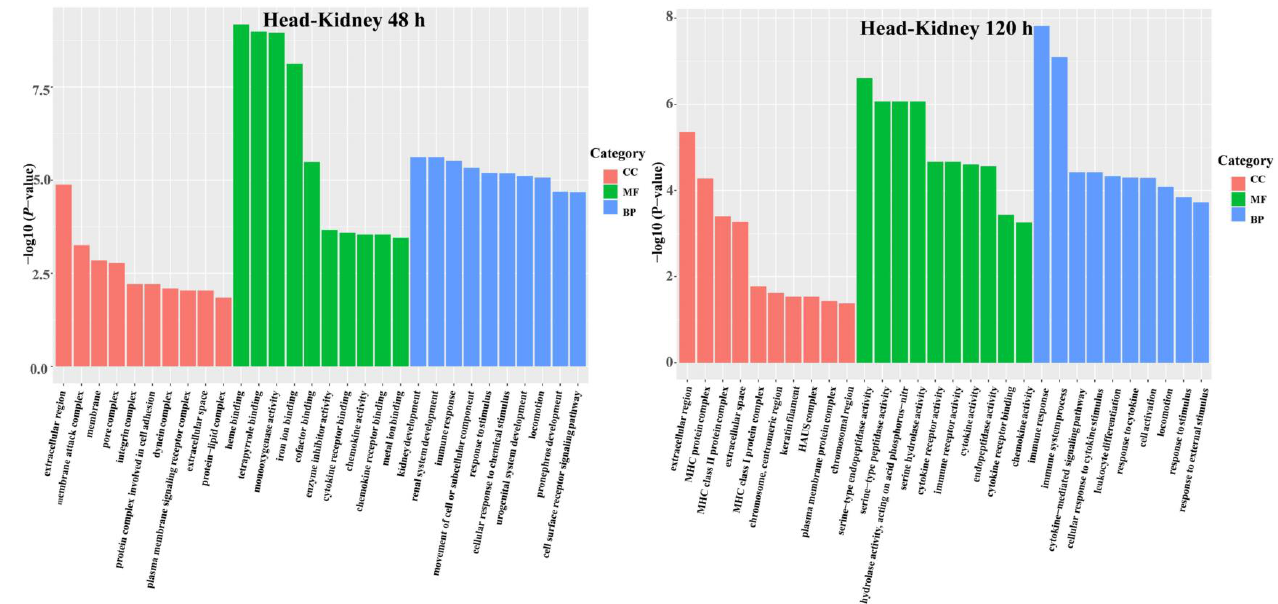
Figure 1. The 30 most enriched GO terms in the liver, spleen, and head kidney of golden pompano at various time points following S. agalactiae challenge. Notes: CC, cellular component; MF, molecular function; BP, biological process.